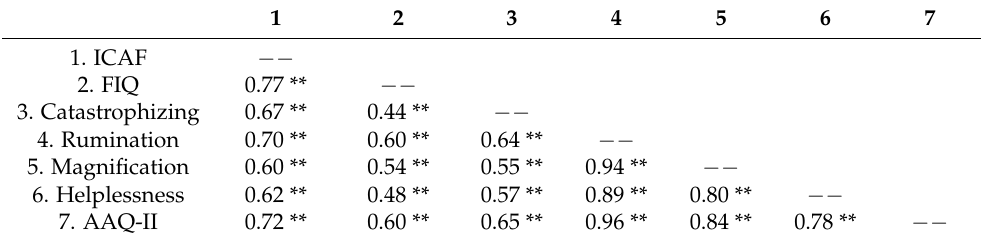
Table 3. Correlations between FM variables and psychological constructs ( N =